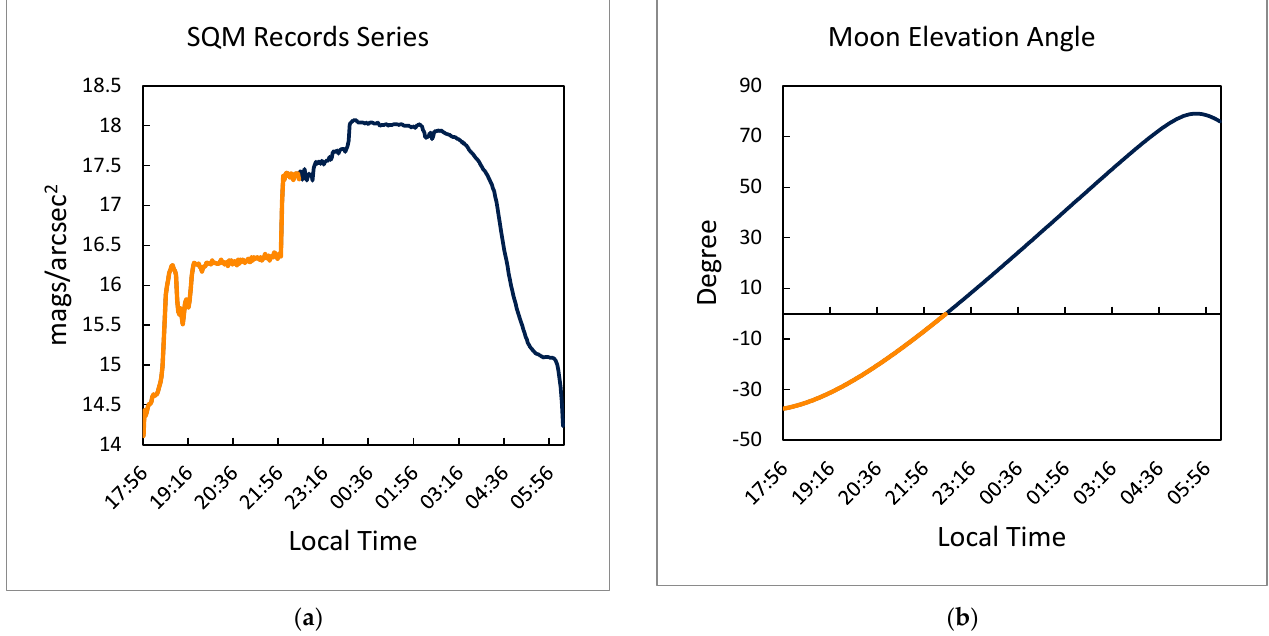
Figure 3. ( a ): The SQM records series obtained between 17:56 18 November and 6:20 November 2019; ( b ): The generated moon elevation angle ( − 90 ° ~90 ° ) series for the SQM records series. Only the SQM records acquired before 22:34 were retained (the orange part) to remove the impact of the